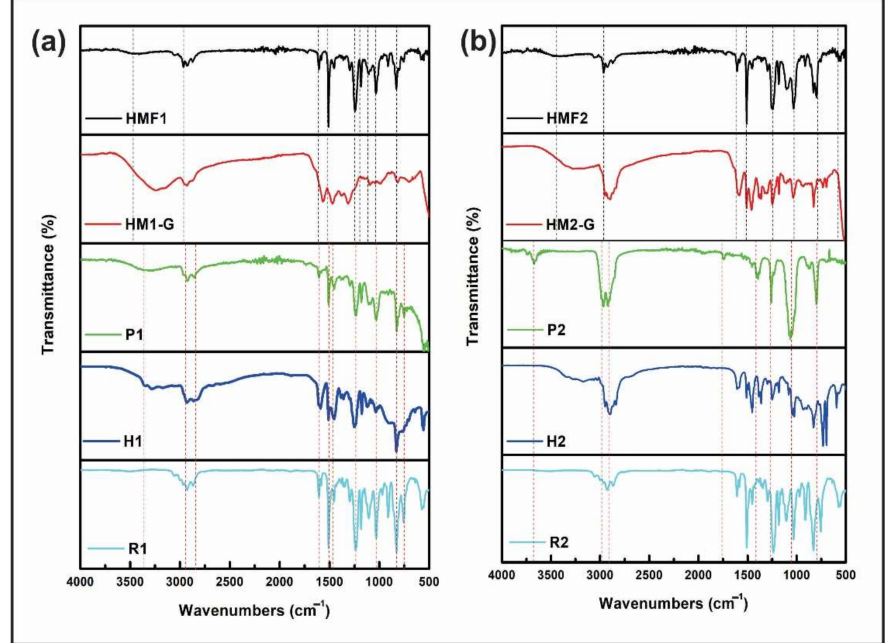
Figure 4. Comparison of FTIR spectra of the hybrid materials obtained (HMF1 and HMF2), obtained with the two resins ( a ) R1 and ( b ) R2, with their respective hardeners. The spectrum of the single cross-linked resin (P1 and P2) and the resin mixed with the GPTMS is presented to verify